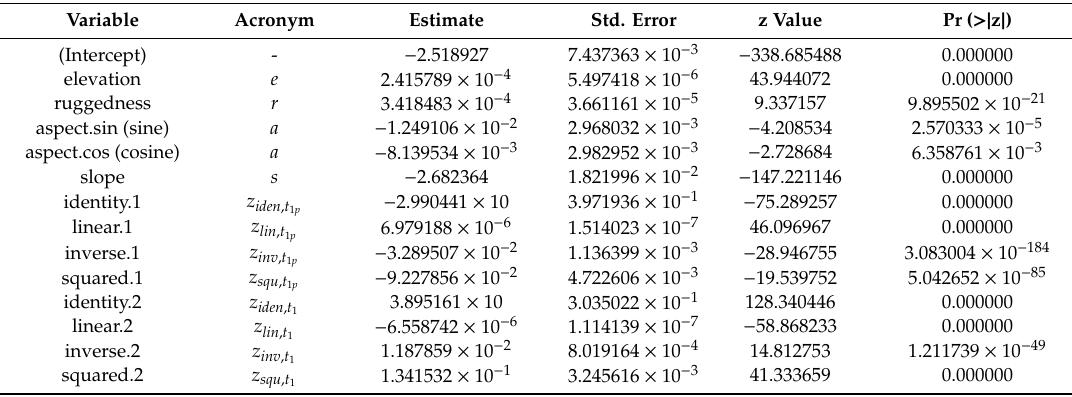
Table A1. Parameterization statistics for the GLM1